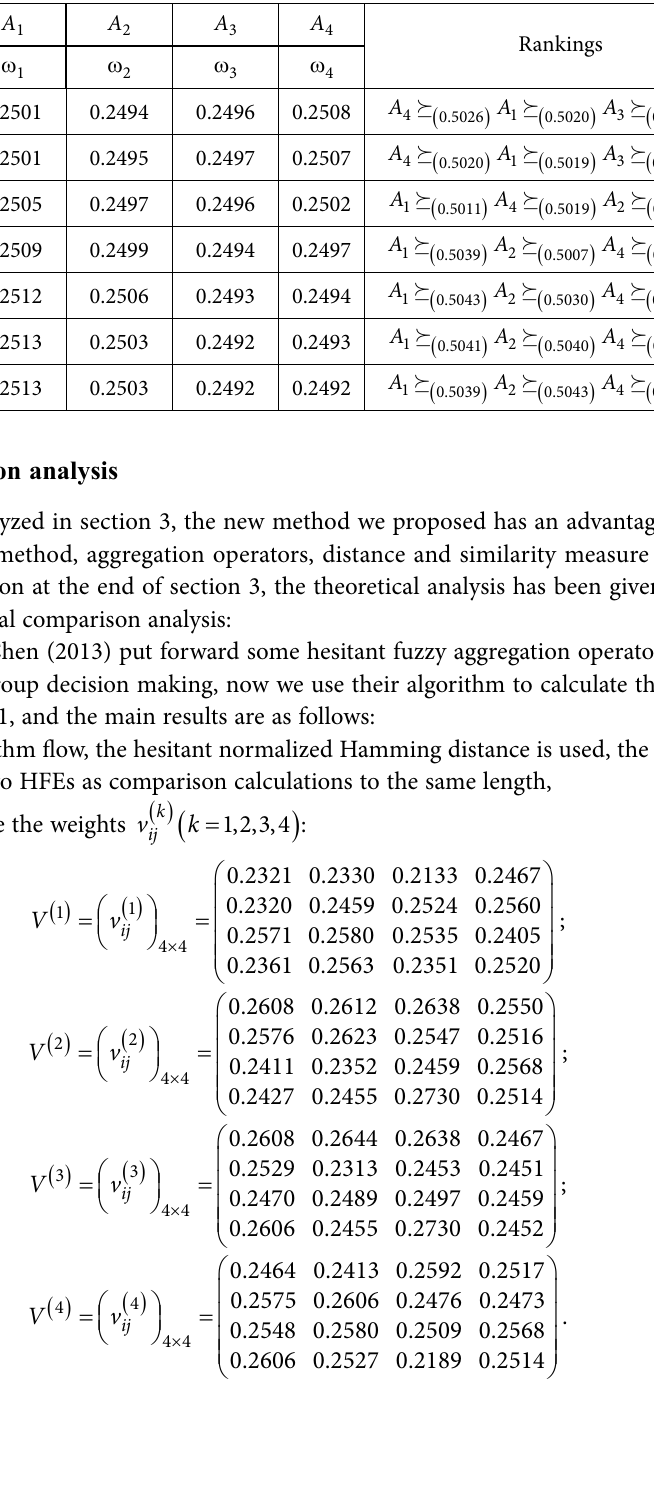
Table 5. Results obtained by different